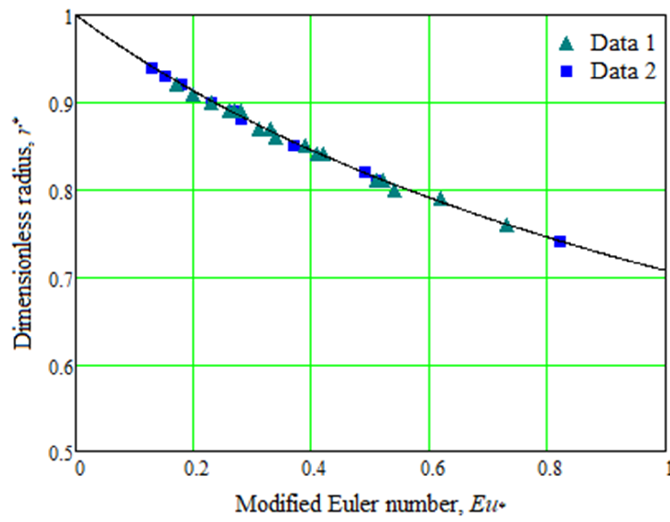
Figure 6. Dependence of the dimensionless radius on the modified Euler number.